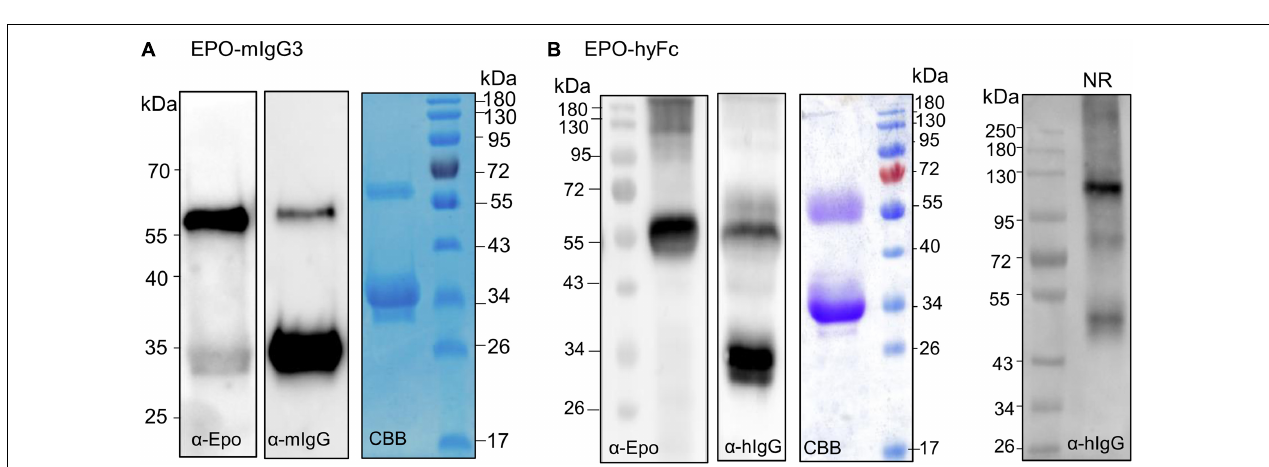
FIGURE 2 | Analysis of the expression of EPO-IgG1 variants. Total soluble protein (TSP) extracts from N. benthamiana (cid:49) XTFT leaves expressing different EPO-Fc variants were analyzed by immunoblotting at 5 days post-infiltration (dpi) using (A) anti-EPO and (B) anti-hIgG antibodies. (C) EPO-Fc variants purified out of TSP with protein A were stained with Coomassie Brilliant Blue under reducing conditions (CBB). (D) Oligomerization of EPO-Fc variants was evaluated in 8% native PAGE of TSP non-reducing samples. Ponceau staining shows similar amounts of protein loaded. Protein size markers are shown in kilo Dalton (kDa).